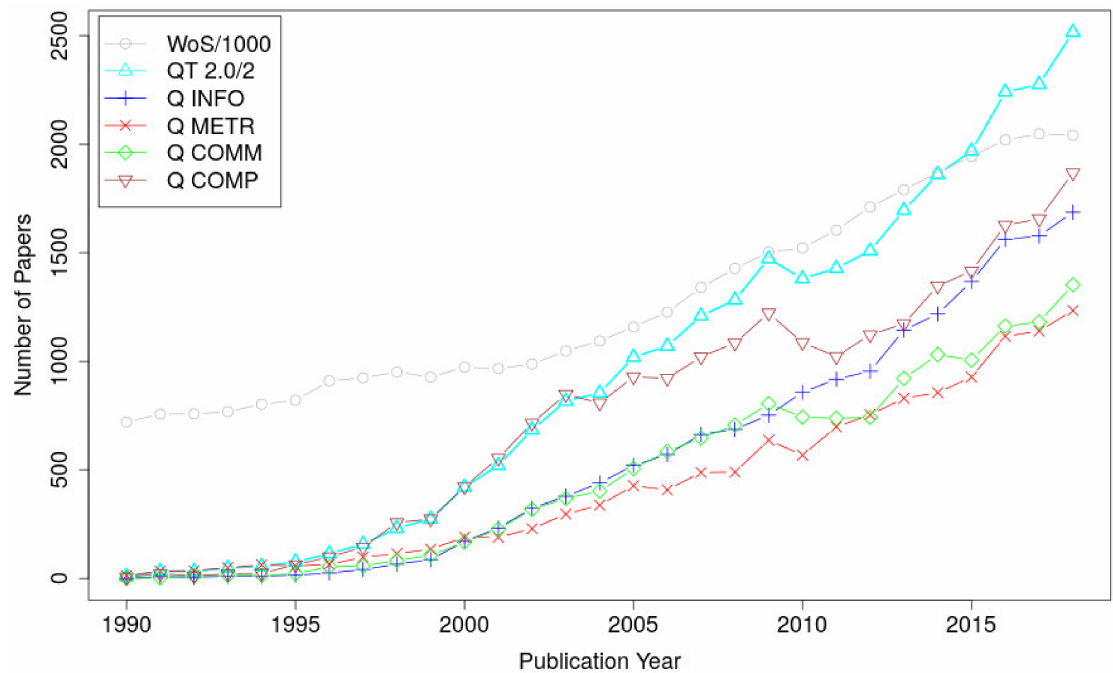
Figure 2. Annual numbers of publications of QT 2.0 and its four fields between 1990 and 2018 (in earlier years the annual numbers of all fields together never exceed 12) compared to the number of articles, reviews, and conference proceedings in the whole WoS. The numbers for QT 2.0 and the whole WoS are scaled by factors 2 and 1000, respectively, for better